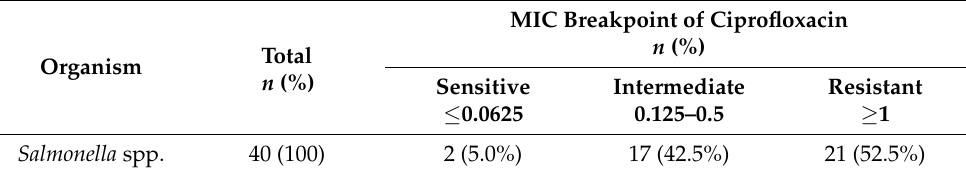
Table 3. Minimum inhibitory concentration of ciprofloxacin against Salmonella isolates.